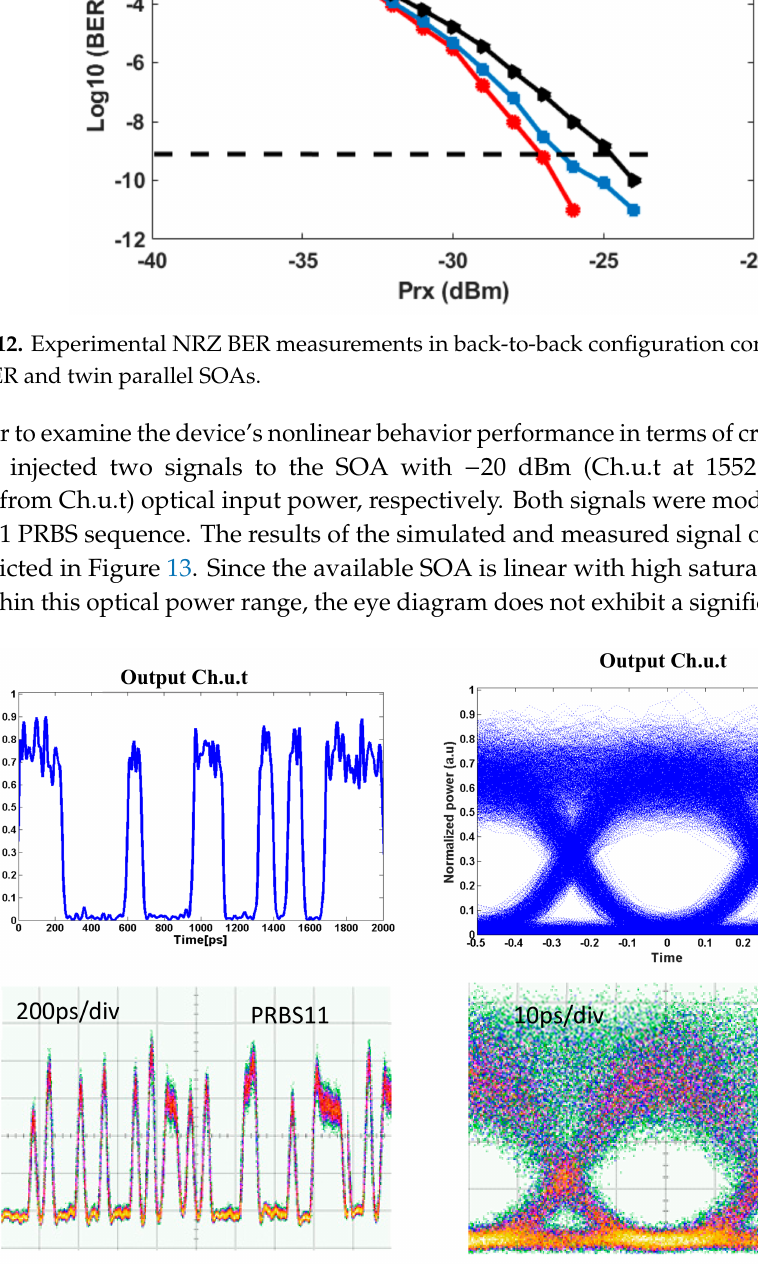
Figure 13. Finding the cross gain modulation (XGM) point for the linear SOA (25 Gb / s NRZ), simulation data (top row) versus experimental (bottom